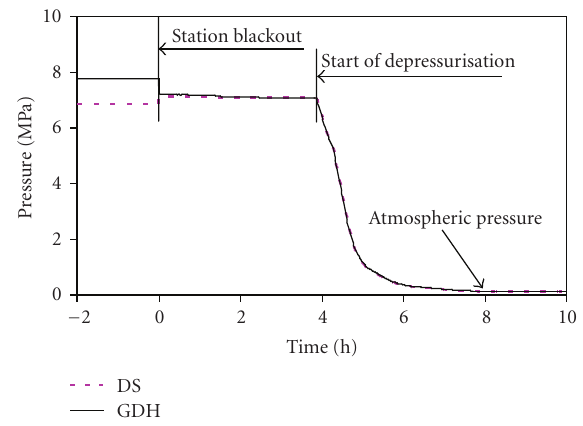
Figure 6: Station blackout case. Pressure behaviour in RCS.